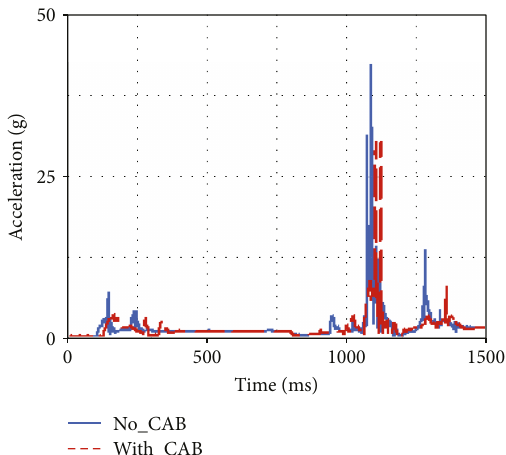
Figure 11: Upper neck F